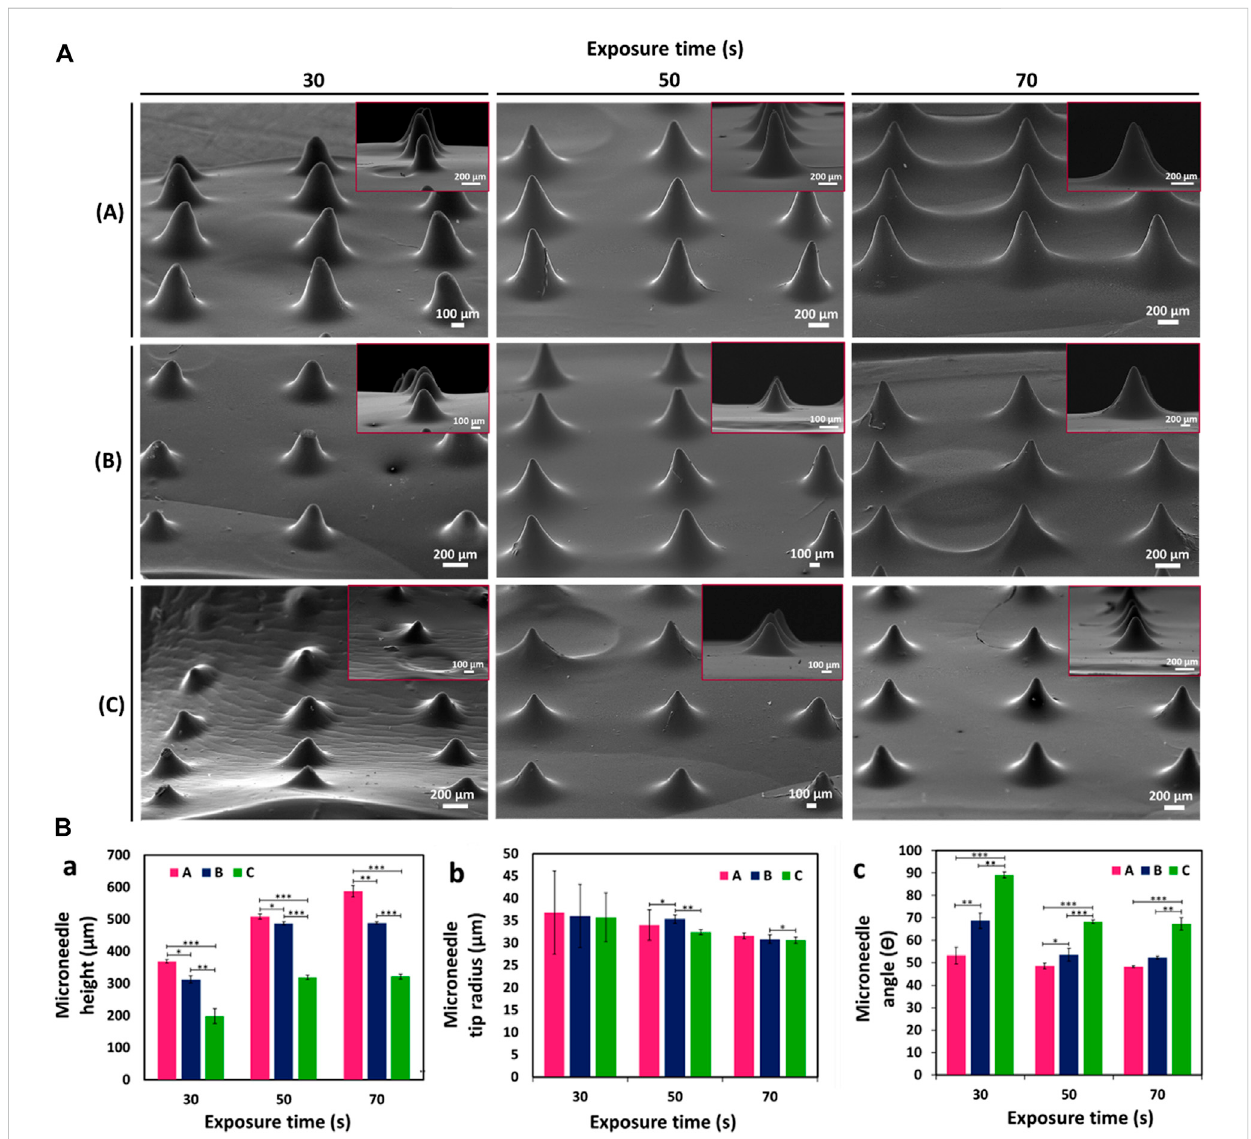
FIGURE 5 (A) SEM images of GelMA MNs designed in three different needle heights according to varying exposure times: (a) 1000 µm height, (b) 750 µm height, and (c) 500 µm height. (B) Variation of (a) height (b) tip radius and (c) angle of GelMA MNs according to exposure times. Statistical difference is indicated with * p ≤ 0.05, **p < 0.01, and *** p < 0.001. Error bars represent the standard deviations (SDs) of measurements performed on at least three